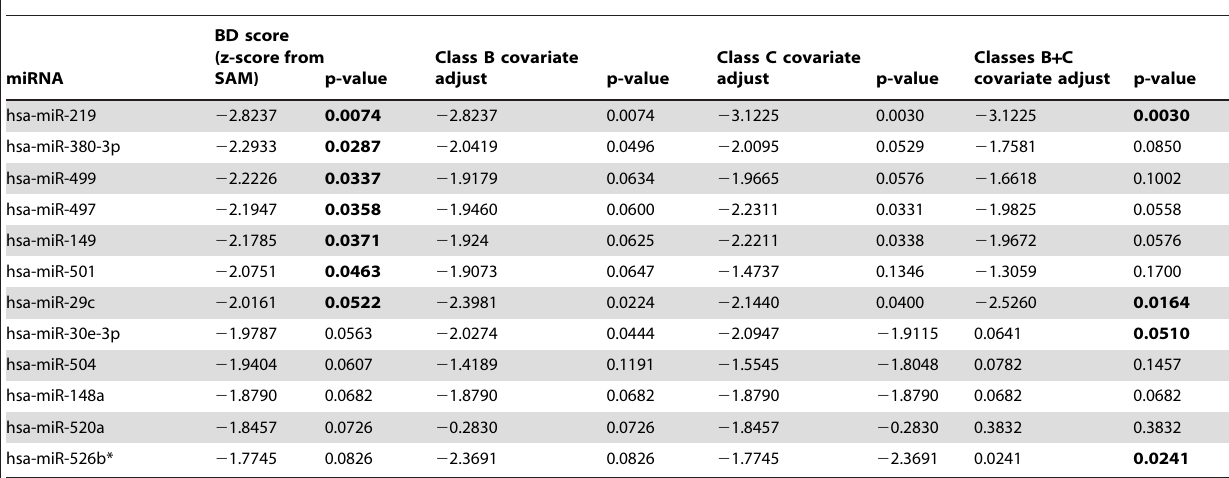
Table 8. Top-ranked miRNAs from Table 3, adjusted for covariate effects of medications (classes B, C, and B + C).